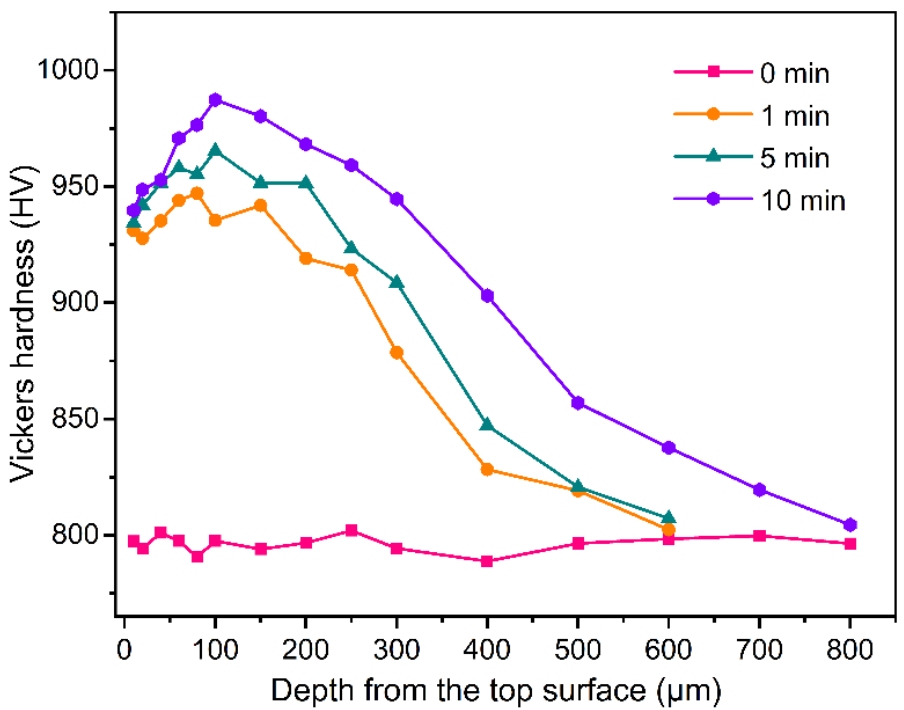
Figure 8. Vickers hardness distribution at different depths from the surface of the M50 steel with different USP durations.